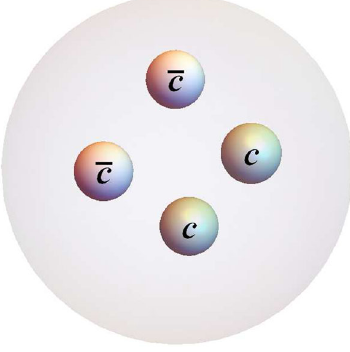
Fig. 3 The narrow cc ¯ c ¯ c structure near 6.9